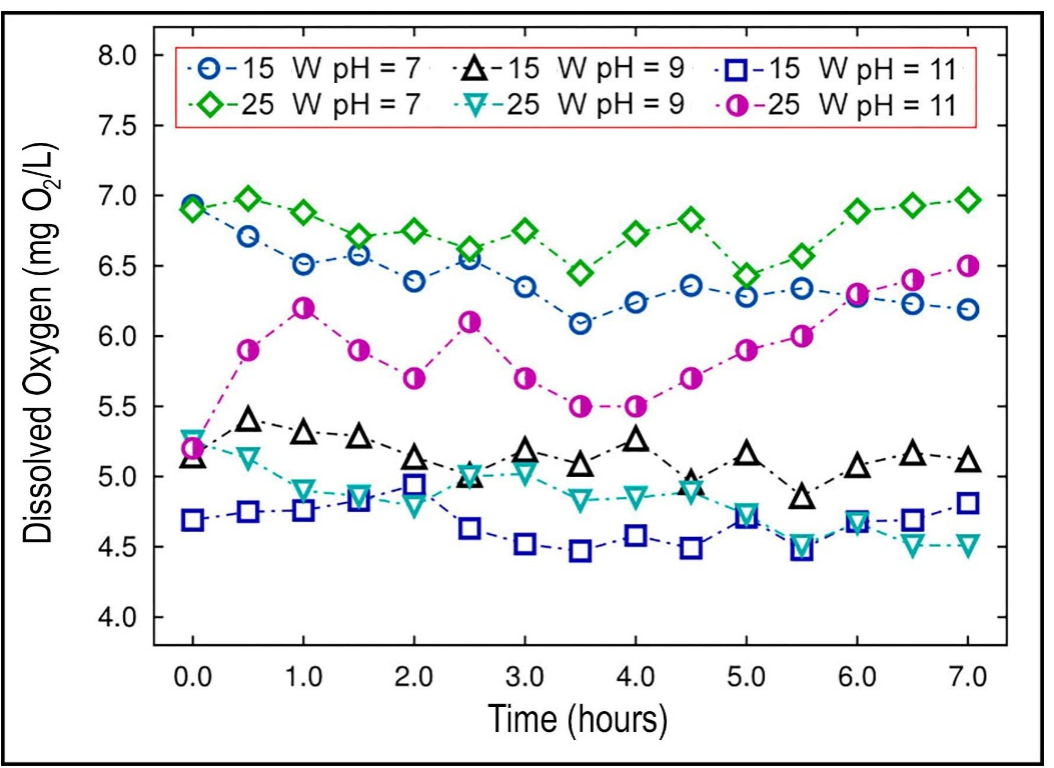
Figure 2. Dynamics of dissolved oxygen in the samples during NH 4+ /NH 3 removal process by photocatalysis. Q = 1000 L/h, temperature = 20 ± 1 °C.